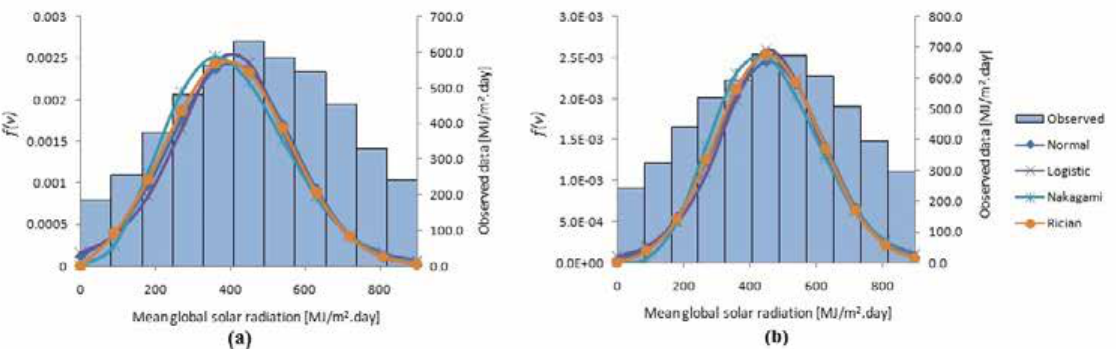
Fig. 9: Fitting pdf to the global solar radiation data; (a) Girne and (b) Lefkoşa Table 5: Global solar radiation distribution parameters for selected regions throughout the period and the selected distribution ( in bold ) for each station